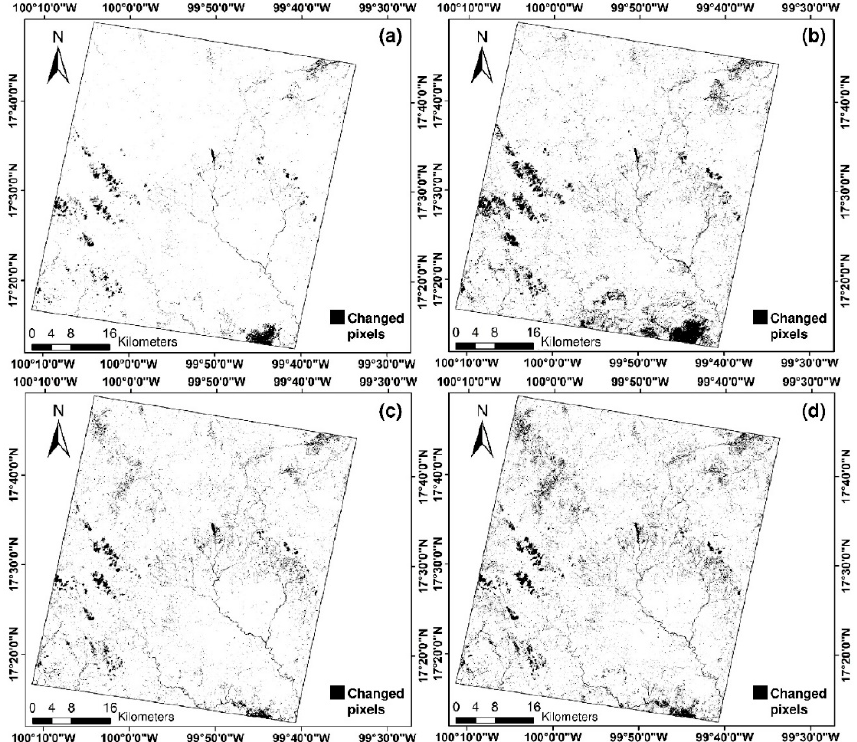
Figure 11. Categorical change maps resulting from the ( a , c ) statistical and ( b , d ) secant thresholding methods applied to change images ( a , b ) LR-PC1 and ( c , d ) LR-NDVI. Table 1. Threshold values and change ratio resulting from the threshold definition.